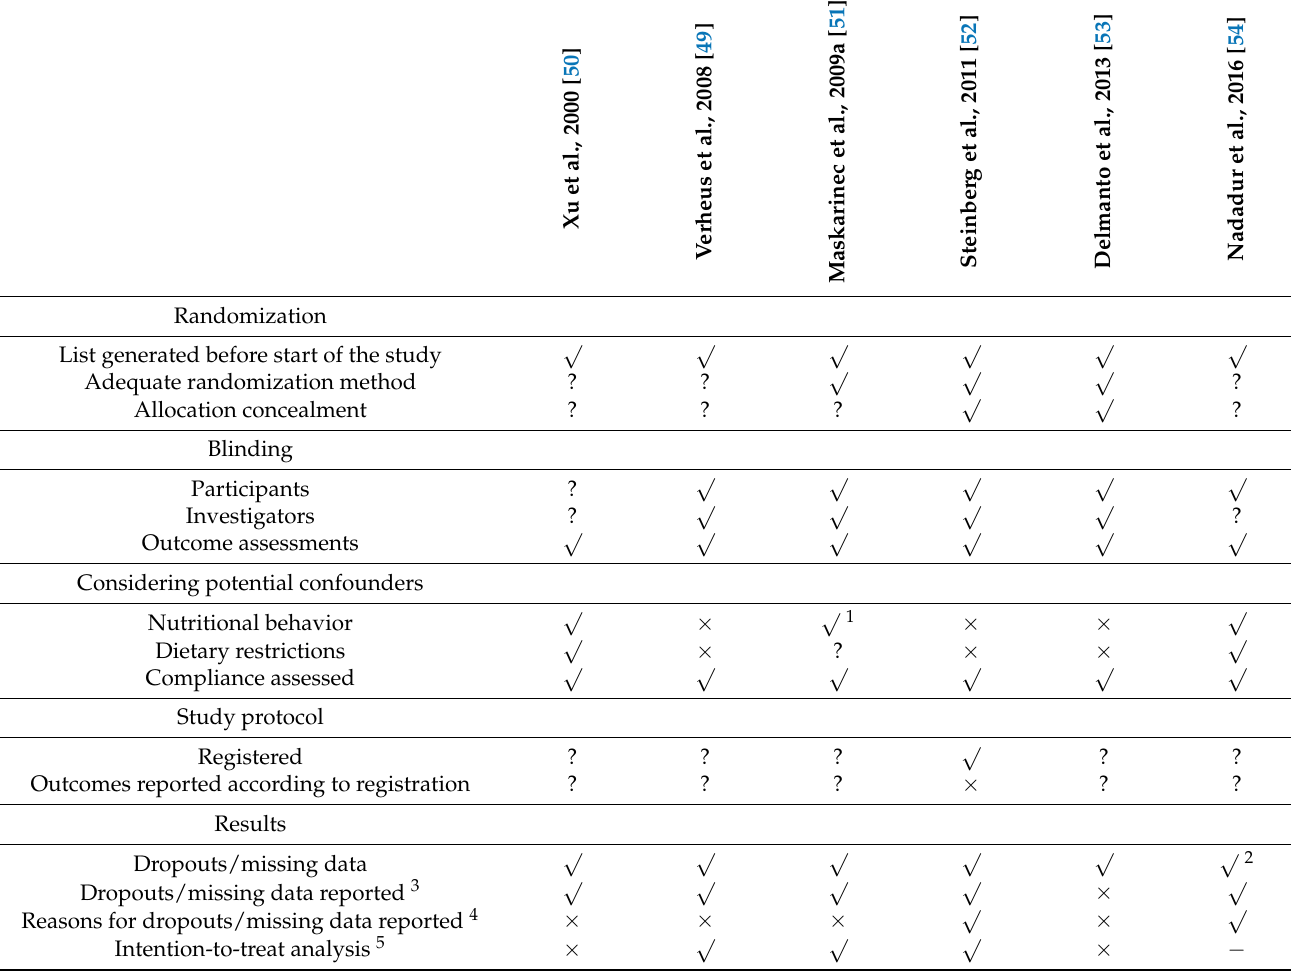
Table 5. Criteria to assess the risk of bias in studies with postmenopausal